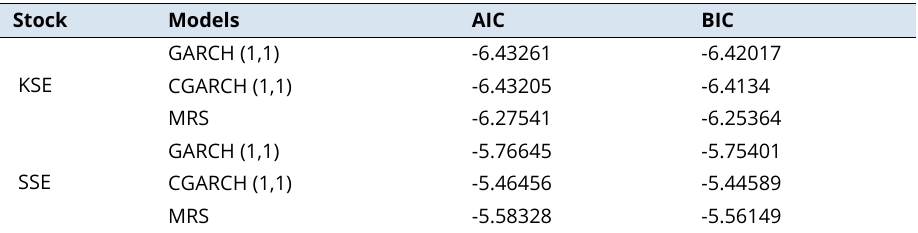
Model selection based on AIC and BIC criteria